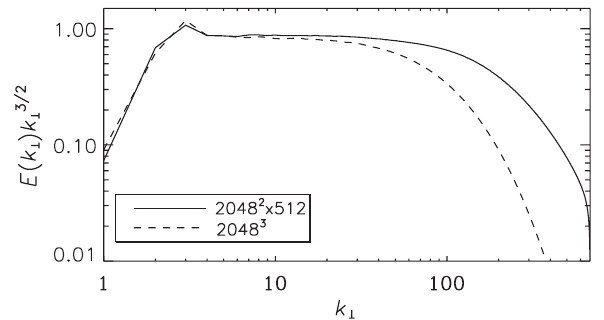
FIG. 6. Energy spectra for runs RB3a (solid line) and RB3d (dash line). Simulation RB3a on 2048 2 (cid:8) 512 has an unresolved dissipation at the expense of a longer inertial interval. Simulation RB3d is performed at lower Re to capture alignment in the dissipation region, with a shorter inertial range.